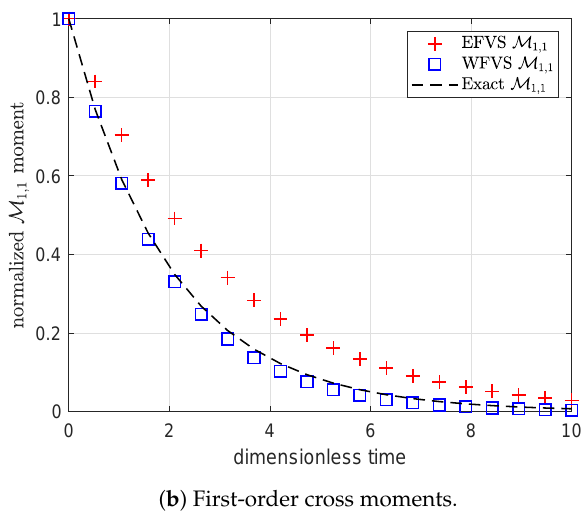
Figure 1. Comparison of different moments with selection function S = 1, and breakage function b 1 .